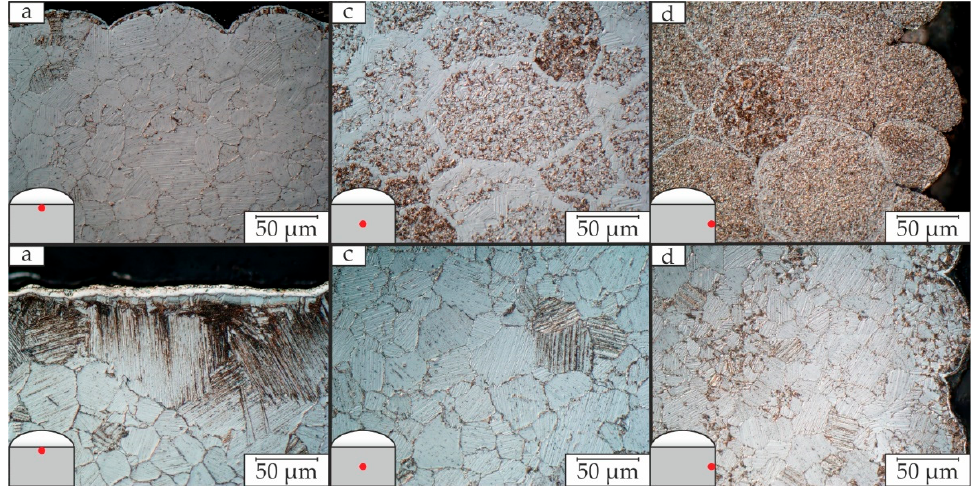
Figure A6. Microstructure in defined positions a, c and d according to Figure 1 (right) of a TNM sample sintered at 1300 °C, with 2 min dwell time and 30 MPa pressure (top) and 10 min dwell time and 65 MPa pressure (bottom).